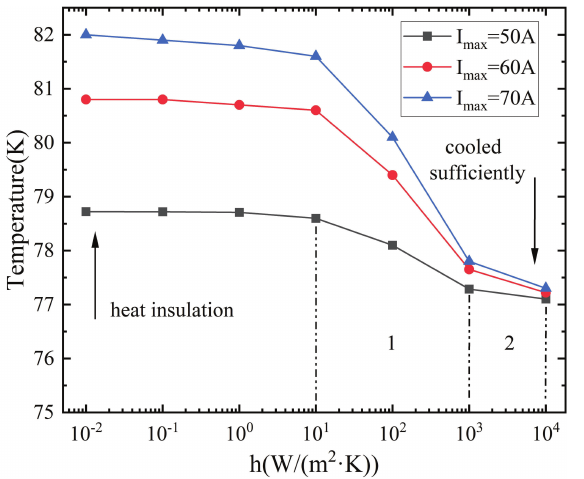
Figure 9. Temperature of the 8th turn of the coil under different the convective heat transfer